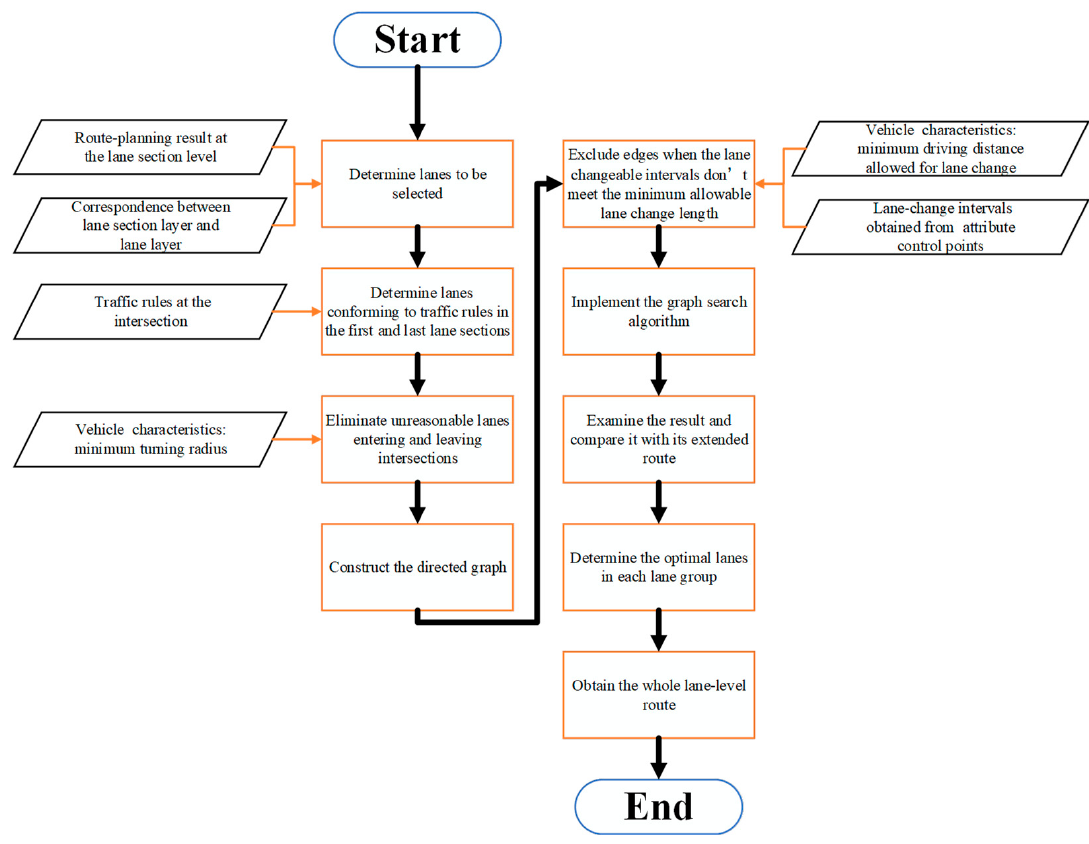
Figure 6. The fl owchart of the optimal lane determination algorithm. Figure 6. The flowchart of the optimal lane determination algorithm.